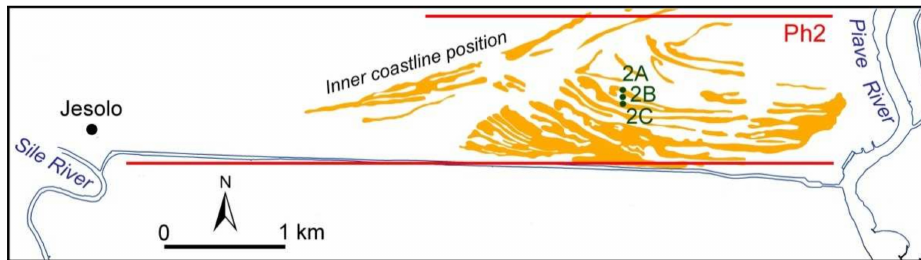
Figure 3. Arrangement of the ancient sandy ridges that define the second progradation phase (Ph2) (rectangle B in Figure 1). The green dots indicate core locations.